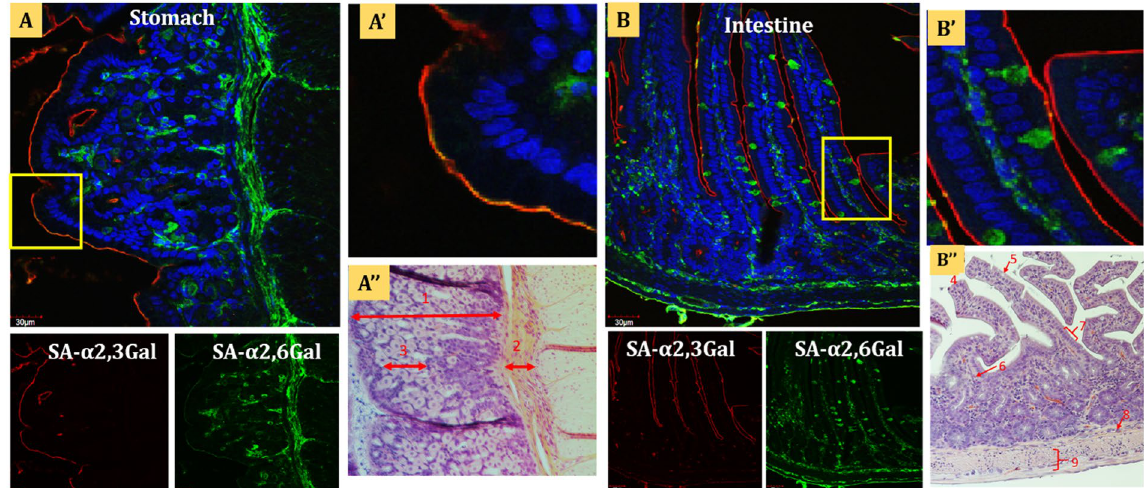
Figure 2. Co-expression of SA α 2,3-Gal and SA α 2,6-Gal receptors in LBB digestive tract. Composite confocal images show co-expression of both SA α 2,3-Gal (red) and SA α 2,6-Gal (green) influenza receptors on the mucosal lining of ( A ) stomach and ( B ) intestine of the little brown bat (LBB). The SA α 2,3-Gal receptor is the predominant receptor type on the mucosal lining of the (A’) stomach and (B’), intestinal villi SA α 2,6-Gal receptor type is more prominent in the lamina propria, muscularis and serosa of the ( A ) stomach and ( B ) intestine. Tissue sections were stained with biotinylated MAAII (red - specific for avian type receptor, SA α 2,3- Gal) and FITC labelled SNA (green - specific for human type receptor, SA α 2,6-Gal) lectins, and DAPI nuclear stain (blue). A”: h aematoxylin and eosin (H and E) stained stomach tissue section. 1. mucosa 2. submucosa 3. mucosal glands. B”: H and E stained intestinal tissue section 4. villus, 5. goblet cell, 6. lamina propria, 7. simple columnar epithelial cell layer, 8. submucosa 9. muscularis.